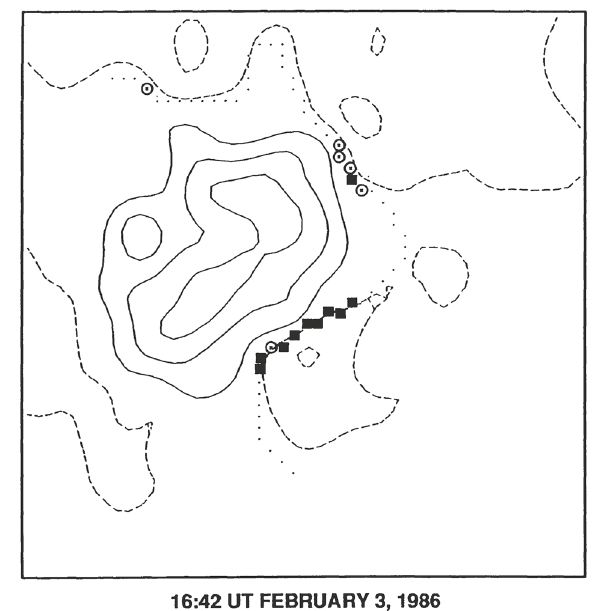
Fig. 6 Map of the line-of-sight magnetic field strength measured in a photospheric line by the MSFC magnetograph. Solid curves denote positive field, dashed curves the negative field, and the dotted curve the neutral line. Circles indicate where the transverse field deviates between 70 ◦ and 80 ◦ from the potential field (perpendicular to the neutral line), and filled squares indicate deviations > 80 ◦ . A large flare (X3 class) occurred several hours later at the location of the largest shear. Image reproduced with permission from Hagyard et al. (1990), copyright by